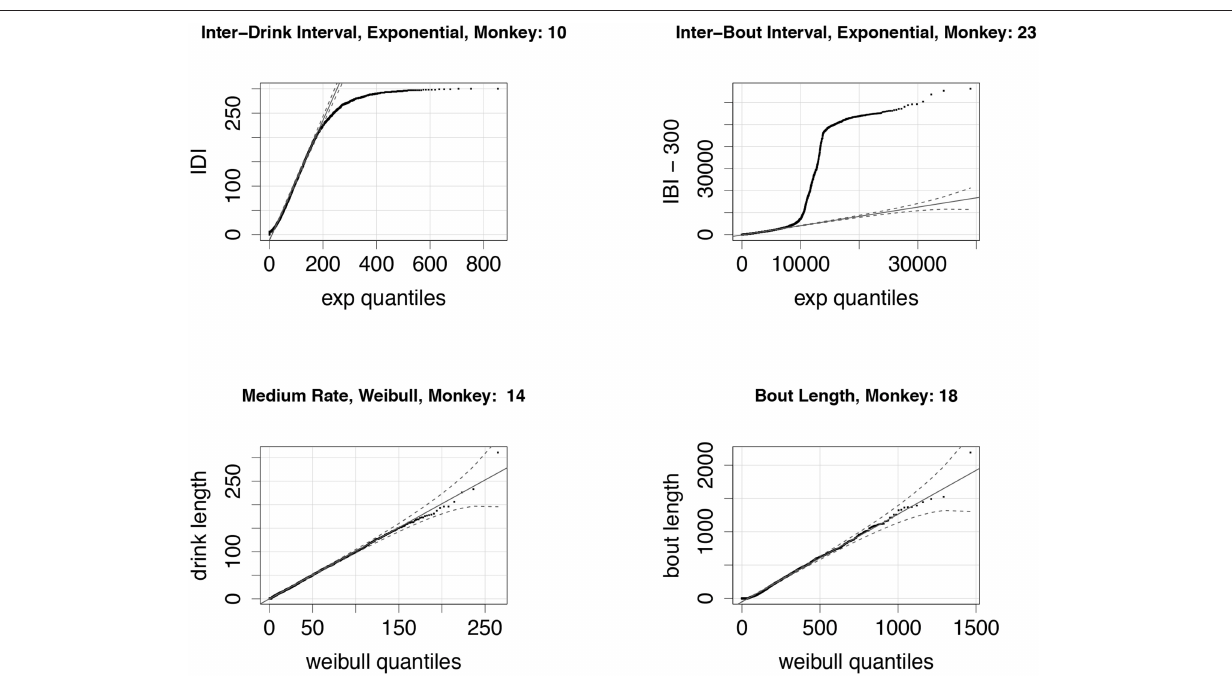
Frontiers in Applied Mathematics and Statistics |